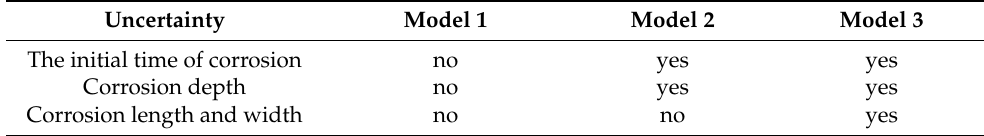
Table 3. Three gradually improved